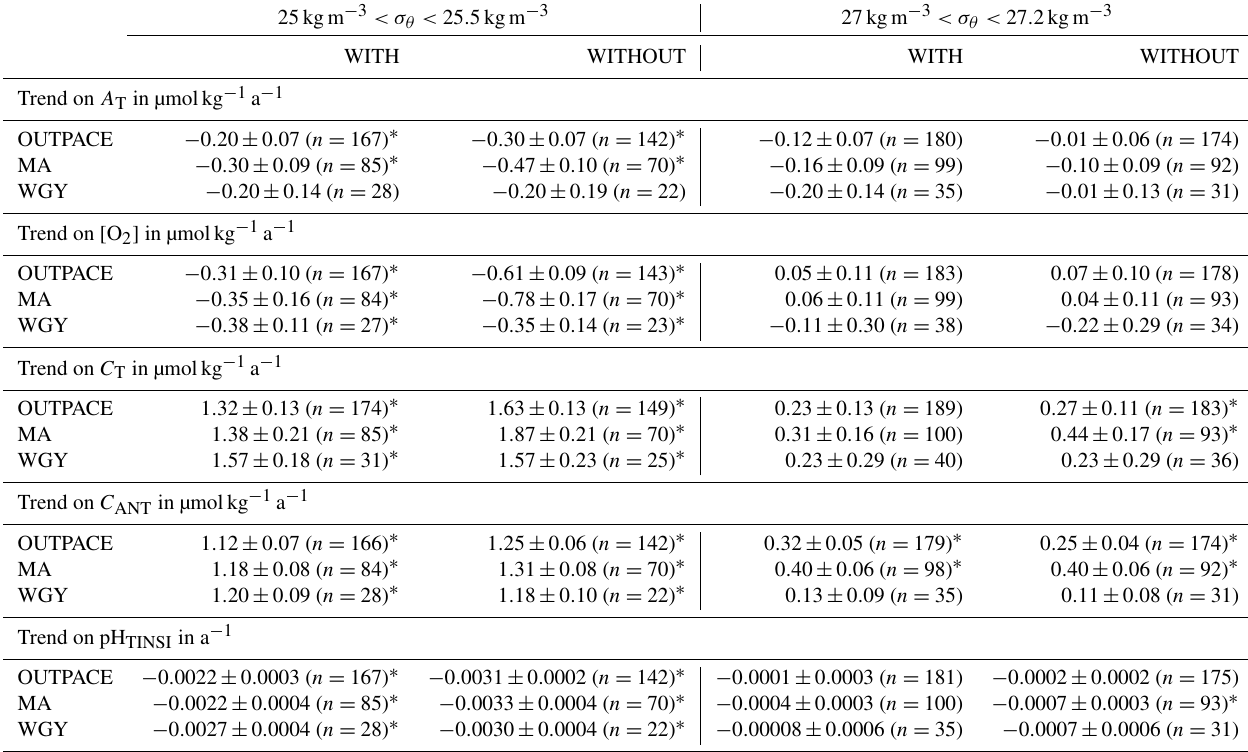
Table 2. Estimated trends on A T , [O 2 ], C T , C ANT and pH T changes in two different layers of the water column defined by isopycnal layers between 1980 and 2015 based on GLODAPv2 with (column WITH) and without (column WITHOUT) OUTPACE data added. Estimated trends are obtained from slope values of a linear regression between the studied parameters and